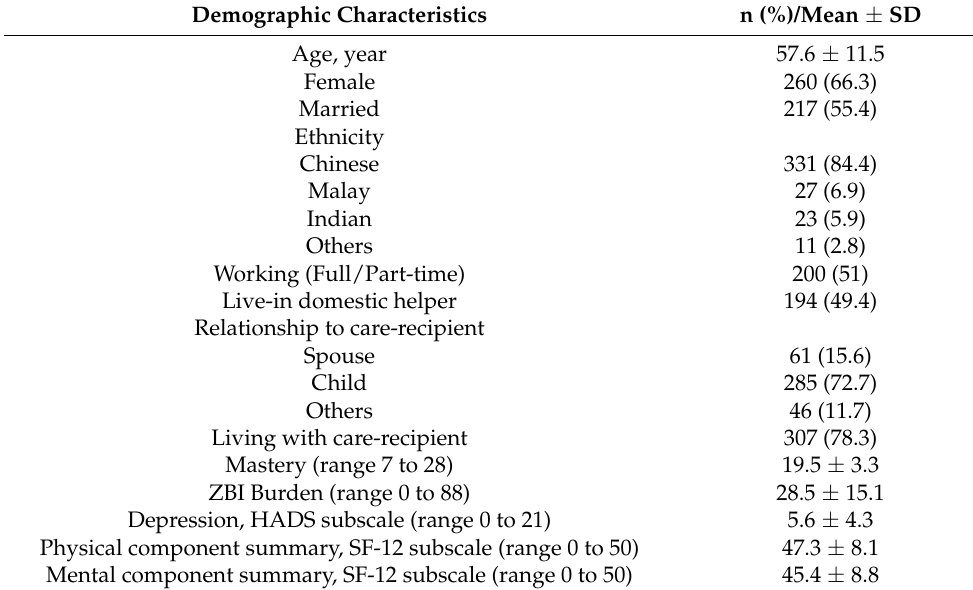
Table 1. Demographics characteristics of participants (n =